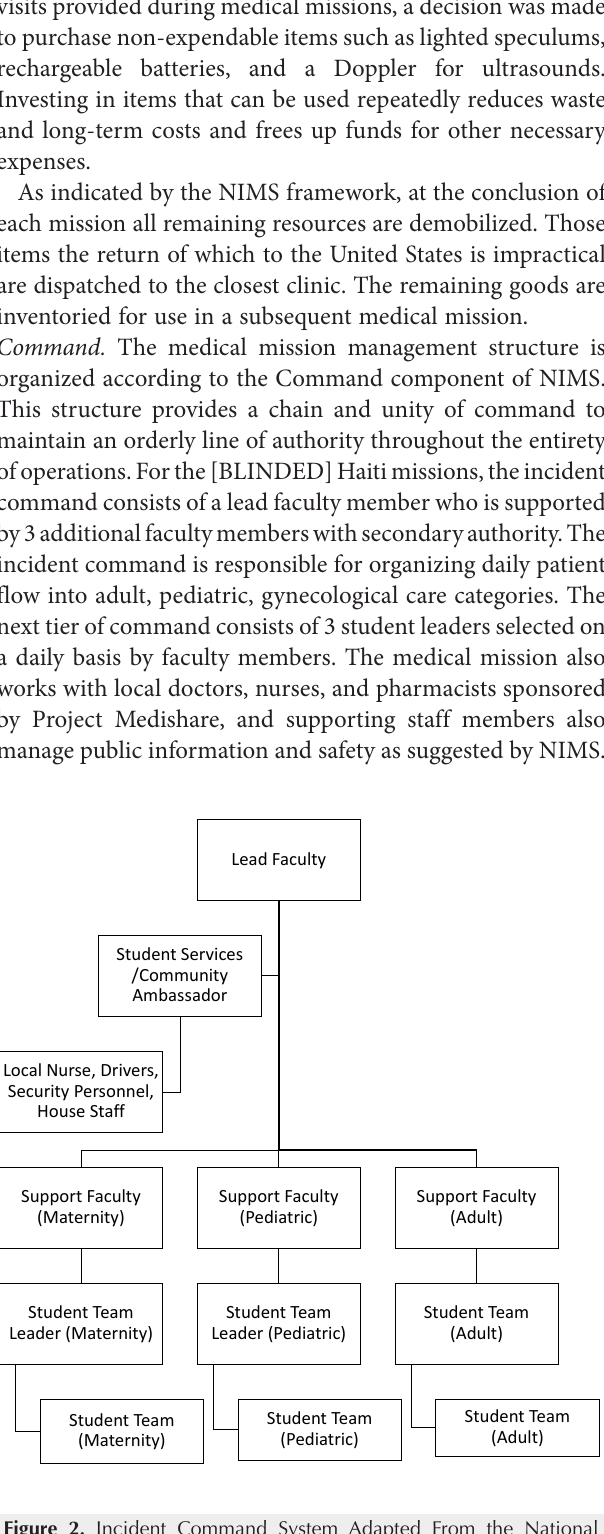
Figure 2. Incident Command System Adapted From the National Incident Management System,